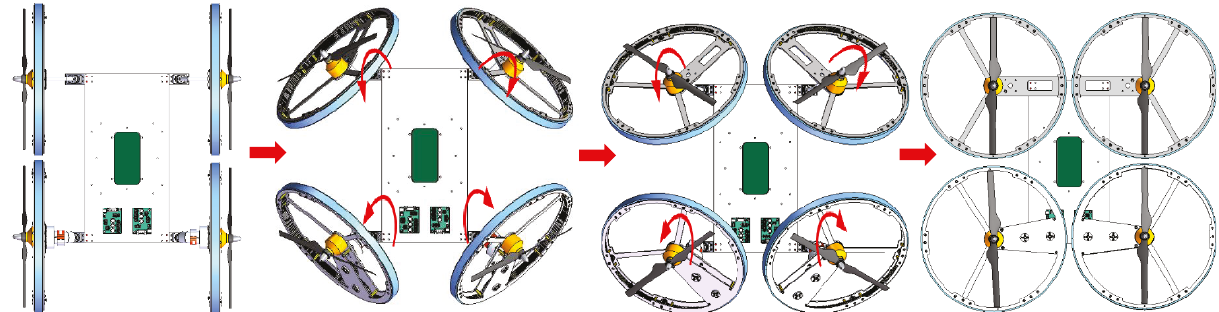
Figure 5: Transformation sequence from terrestrial locomotion mode to aerial locomotion mode.